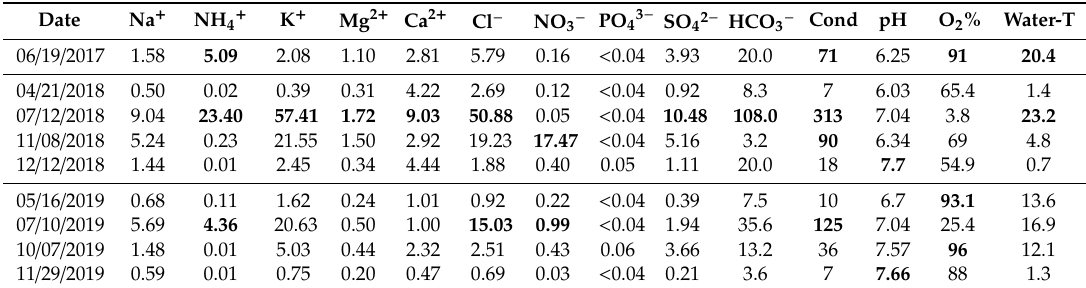
Table 2. Concentrations (mg L − 1 ) of the di ff erent ions measured for each sampling date (Water-T: water temperature in ◦ C; Cond: conductivity in µ S cm − 1 ) (in bold: the highest concentrations and values).